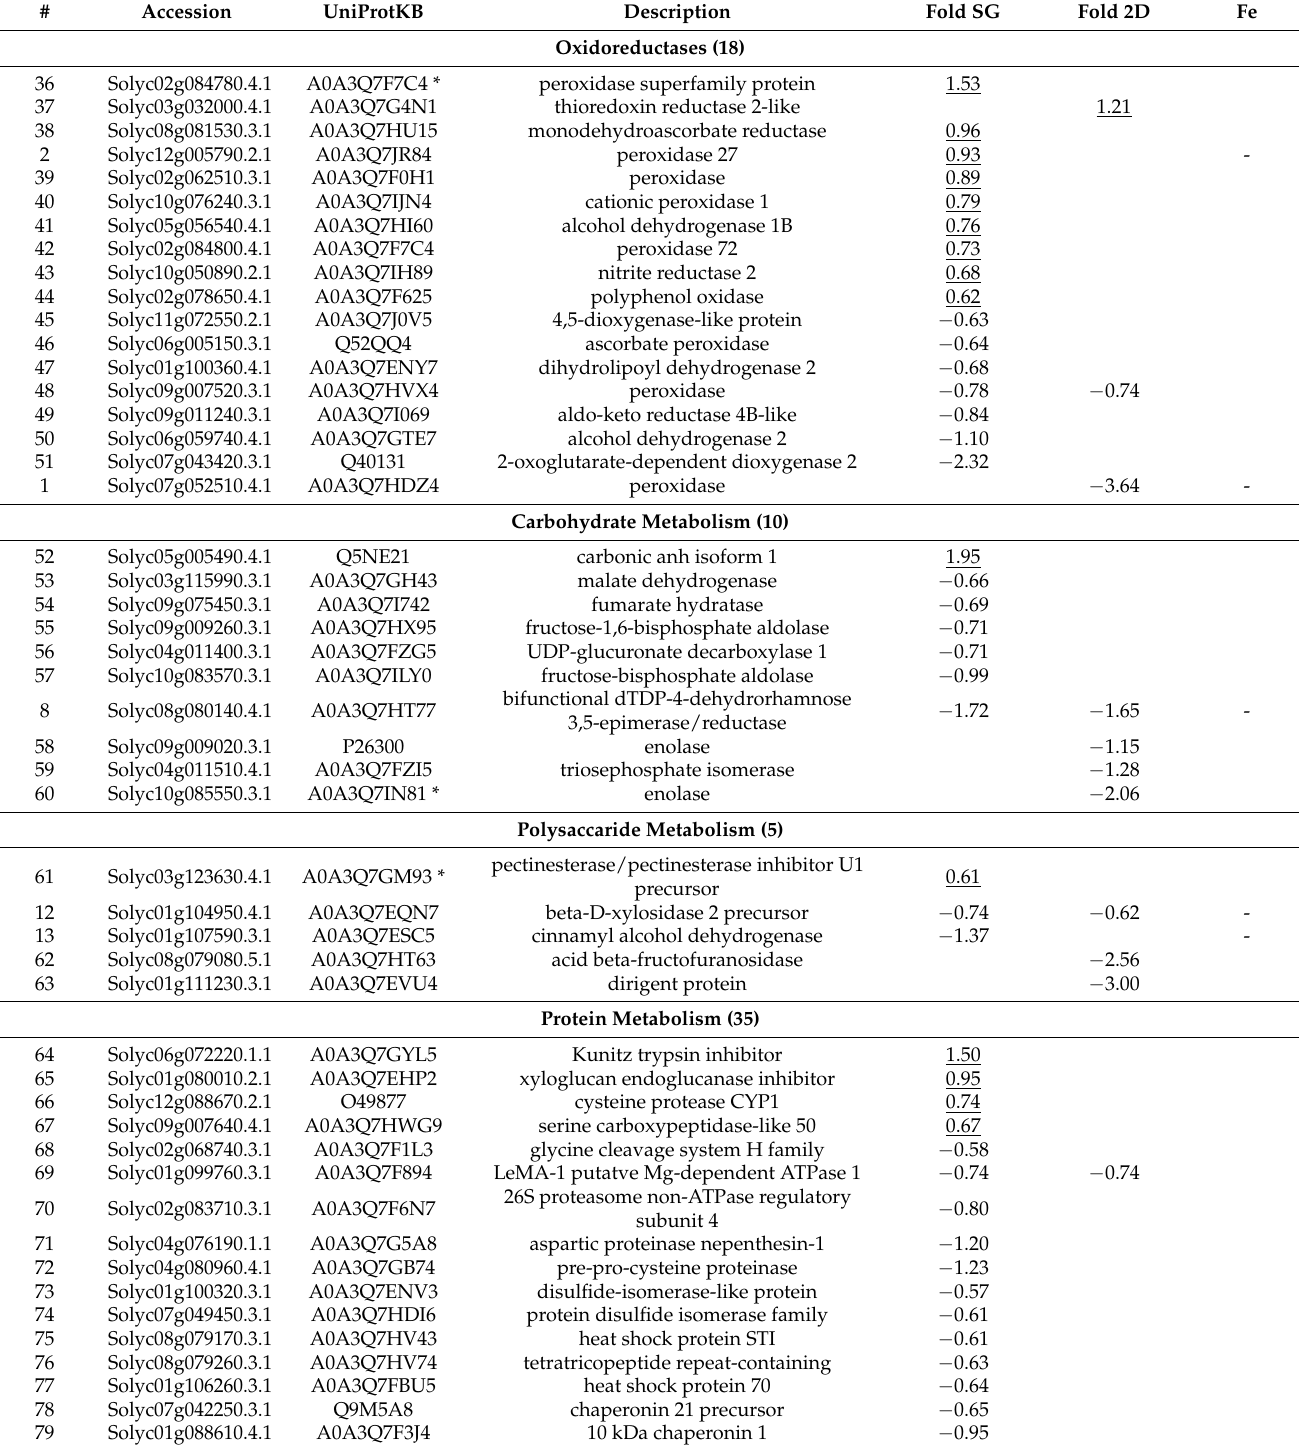
Table 3. Identified and quantified proteins (91 in total) changing in relative abundance by Mn deficiency. Accession code is from the ITAG 4.0 database. Fold SG—fold change found between Mn deficient and control samples by shotgun in a log 2 base. Fold 2D—fold change found between Mn deficient and control samples by 2-DE. Relative abundance increases are underlined for the sake of clarity. Fe—response observed in Fe-deficient samples compared to controls ( − decreased abundance, + increased